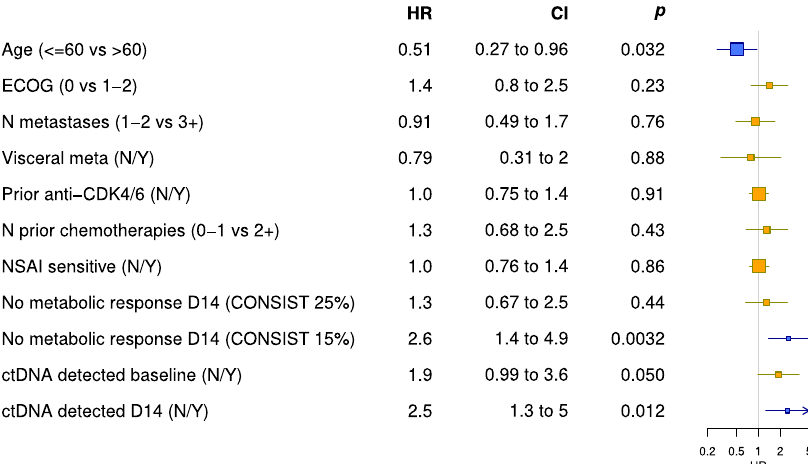
Fig. 4 Impact of clinical and pathological characteristics, 18 F-FDG-PET/CT response and ctDNA detection on PFS (univariate analysis). Blue boxes represent parameters that have a signi fi cant impact on PFS. Yellow boxes represent parameters which doesn ’ t have signi fi cant impact on PFS. Horizontal lines represent CI. X -axis represents HR. CI: 95% con fi dence interval, p: p value, HR: hazard ratio. ECOG = Eastern Cooperative Oncology Group performance status, ranging from 0 to 5, and indicating that the patient is at 0, fully active able to carry on all pre-disease performance without restriction; at 1,restricted in physically strenuous activity but ambulatory and able to carry out work of a light or sedentary nature; at 2, 2 - ambulatory and capable of all self-care but unable to carry out any work activities; up about more than 50% of waking hours; N metastasis = number of metastatic organ sites involved, Visceral meta = presence of visceral metastasis, N = no, Y = yes, N prior chemotherapies = number of prior chemotherapy regimens used for the treatment of advanced breast cancer, NSAI = non-steroidal aromatase inhibitor; sensitive is de fi ned as relapse ≥ 2 years after the end of a NSAI in adjuvant setting or ≥ 6 months treatment in metastatic setting, Consist 25% = <25% homogenous decrease in maximum standardized uptake value (SUVmax) in all target lesions are considered as “ non-responders ” , Consist 15% = <15% homogenous decrease in maximum standardized uptake value (SUVmax) in all target lesions are considered as “ non-responders ”